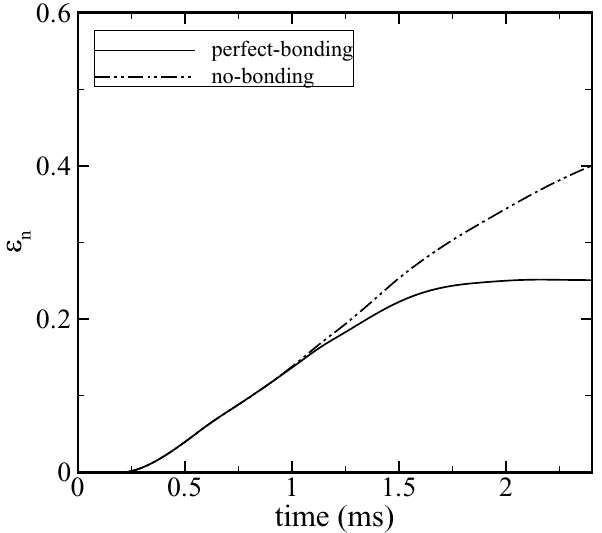
Fig. 9. Comparison of the mid-span nominal compressive strain (cid:5) n history of the foam core between the perfect- and no-bonding sandwich plates with clamped ends. due to higher degree of core compression. This leads to much lower net energy gaining by the no-bonding plate than by the perfect-bonding plate from the UNDEX